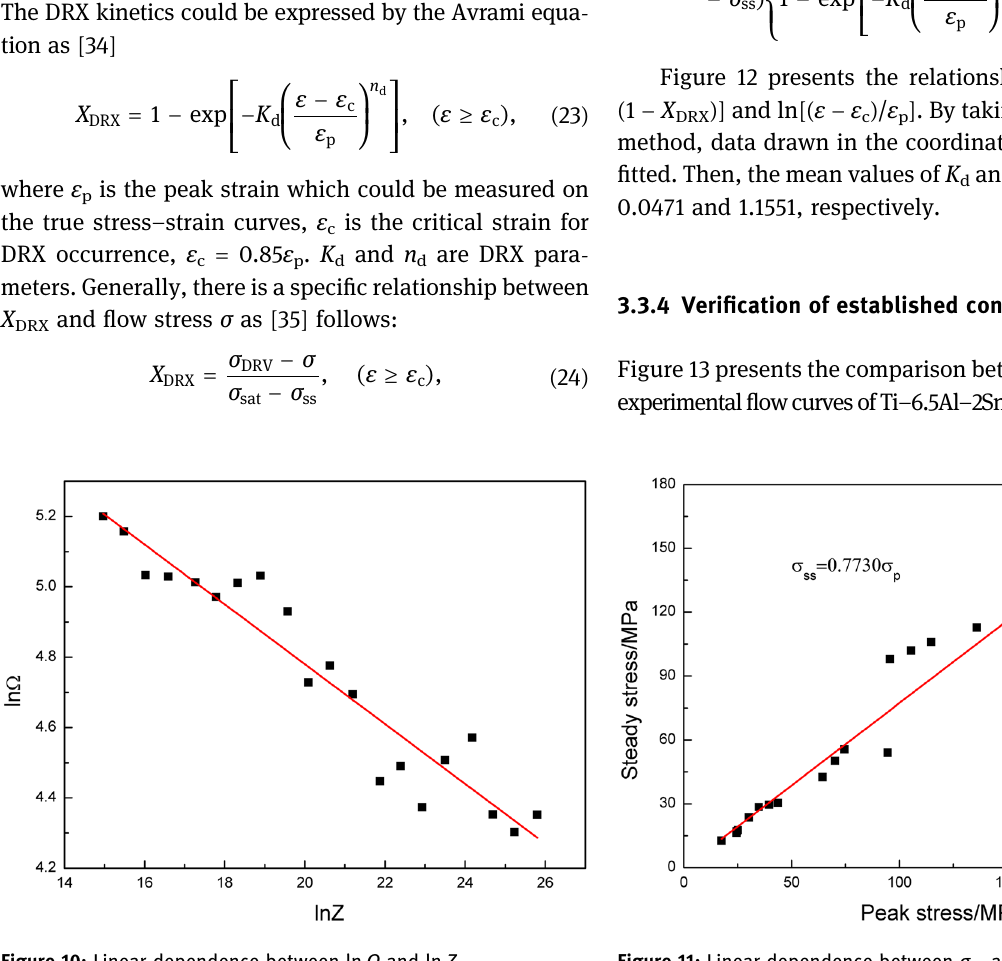
Figure 10: Linear dependence between ln Ω and ln Z . Figure 11: Linear dependence between σ ss and σ p